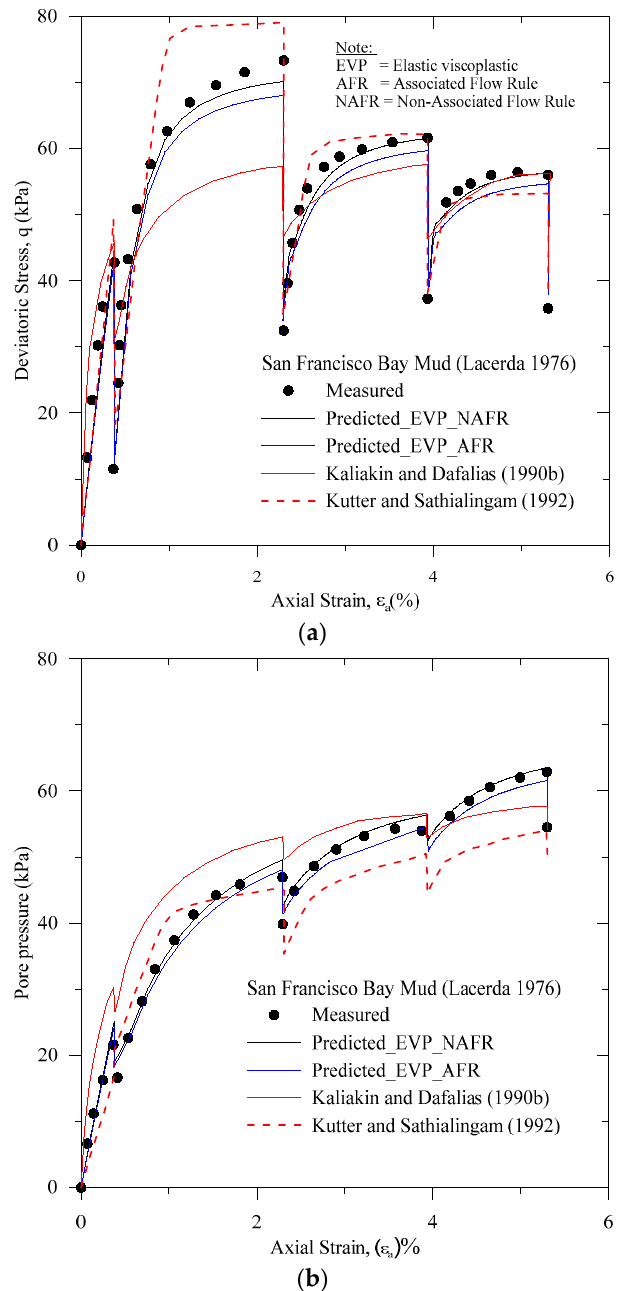
Figure 6. Comparison of the measured and the predicted undrained triaxial tests for the stage-changed axial strain rate combined with stress relaxation on the SFBM clay: ( a ) the deviatoric stress vs. axial strain; and ( b ) the pore pressure vs. axial strain.